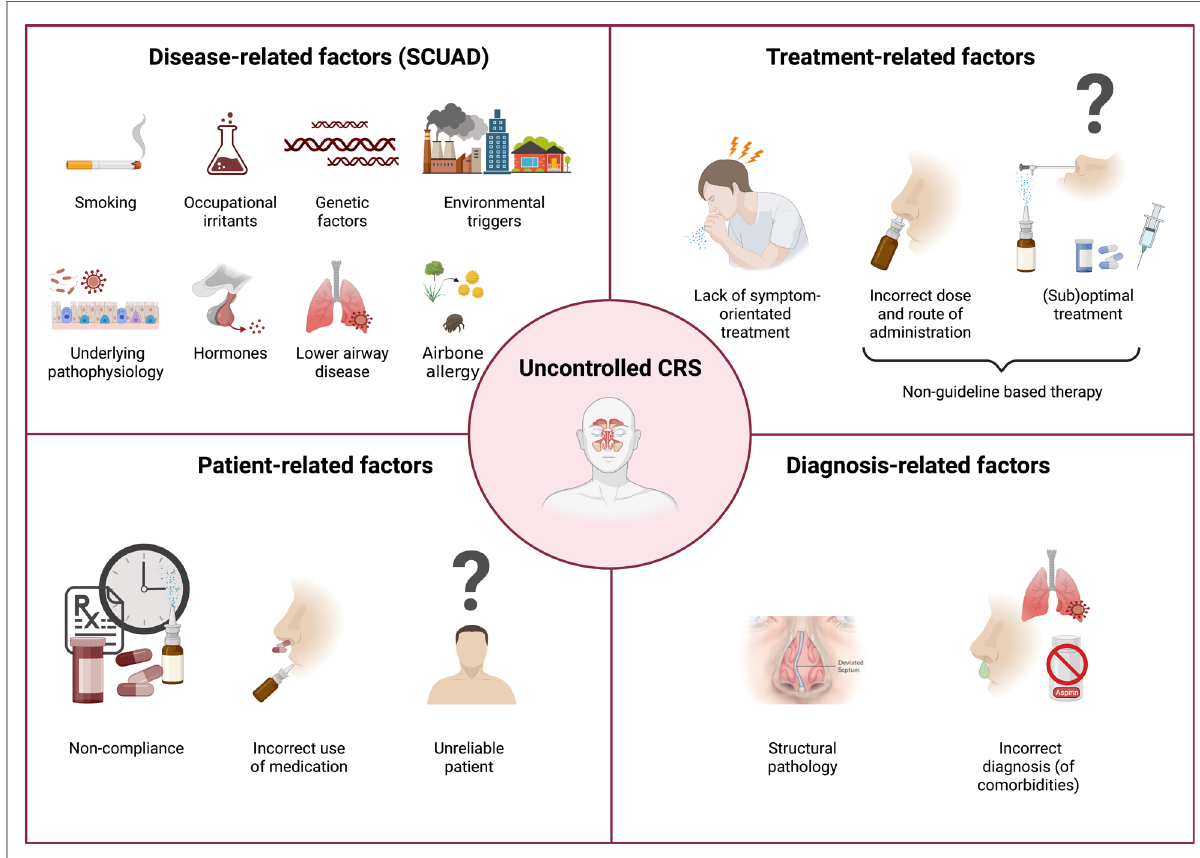
FIGURE 1 Reasons for uncontrolled chronic rhinosinusitis hellings and colleagues reviewed and classi fi ed the reasons for uncontrolled chronic rhinosinusitis (CRS) in the following four groups: disease-related factors, diagnosis-related factors, patient-related factors, and treatment-related factors (Hellings et al .,